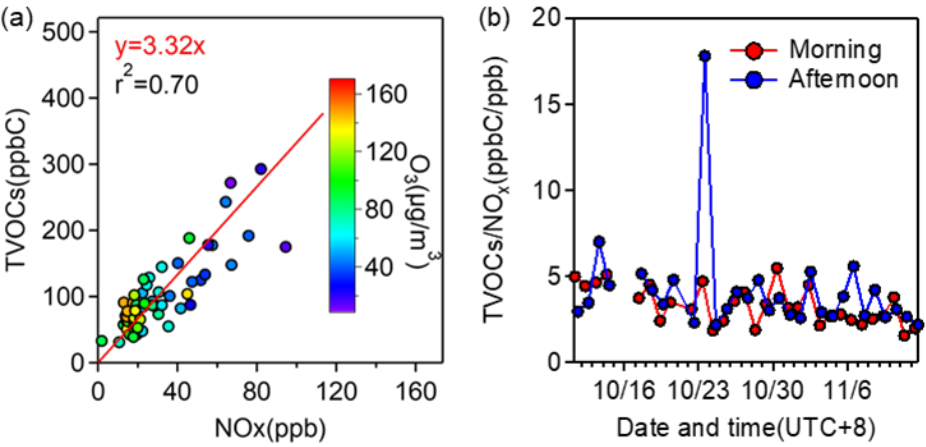
Figure 4. ( a ) Scatter plot of concentrations of TVOC versus NO x , and ( b ) temporal variations of VOCs/NO x (ppbC/ppbv) ratios in morning and afternoon samples, respectively.